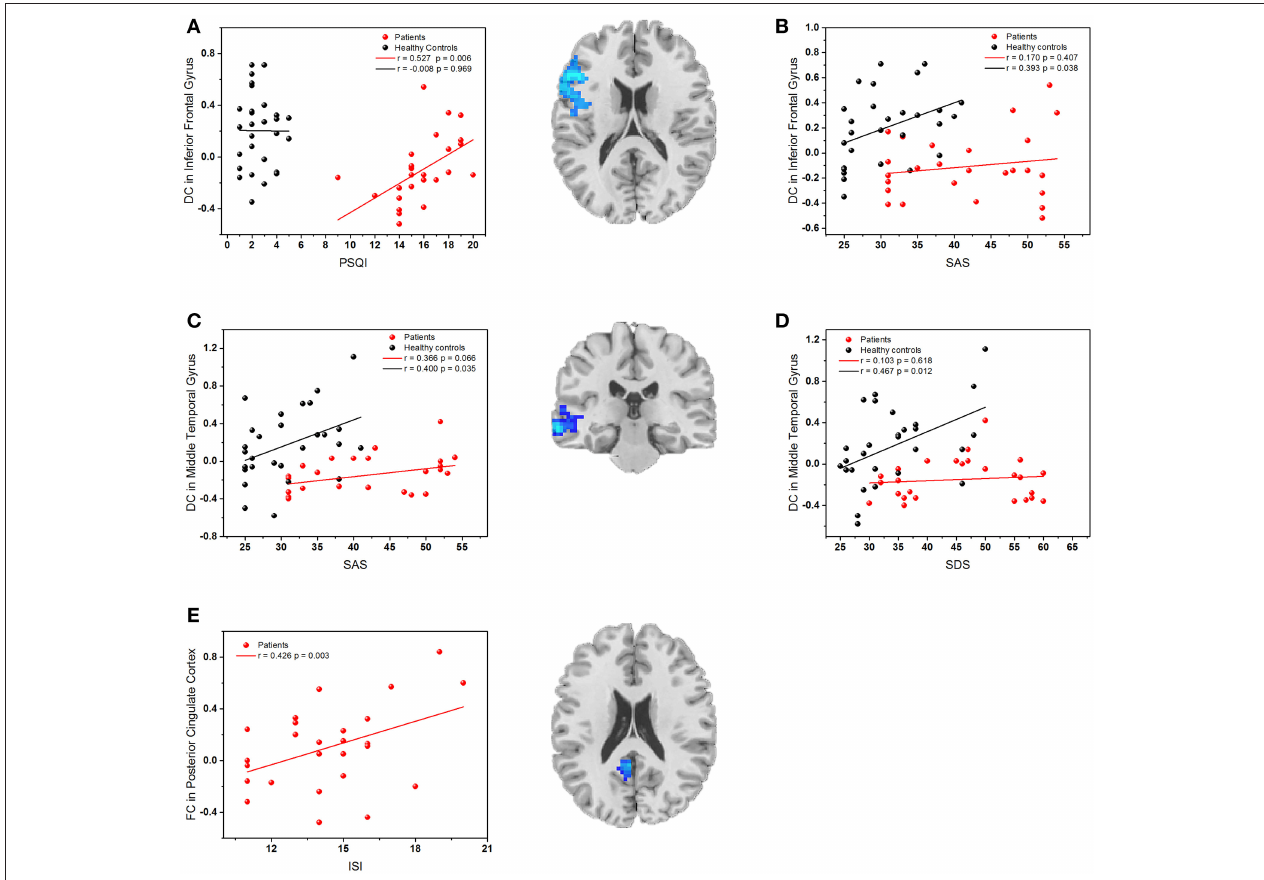
FIGURE 4 | (A) The correlation between the PSQI scores and DC values in the left inferior frontal gyrus; (B) The correlation between SAS scores and DC values in the left inferior frontal gyrus; (C) The correlation between SAS scores and DC values in left middle temporal gyrus; (D) The correlation between SDS scores and DC values in left middle temporal gyrus. (E) The correlation between ISI scores and FC values in left posterior cingulate cortex. Red dots: PI patients; black dots: healthy